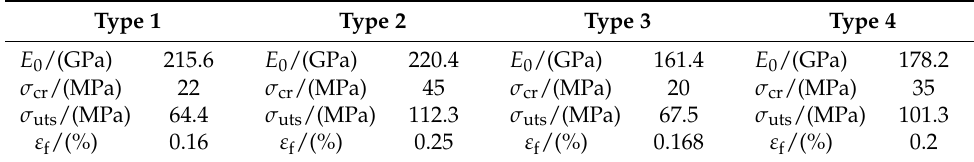
Figure 12. ( a ) Unloading ITM; and ( b ) reloading ITM of Type 4 3D needle-punched C/SiC composite. Table 2. Tensile properties of Types 1–4 3D needle-punched C/SiC composites.